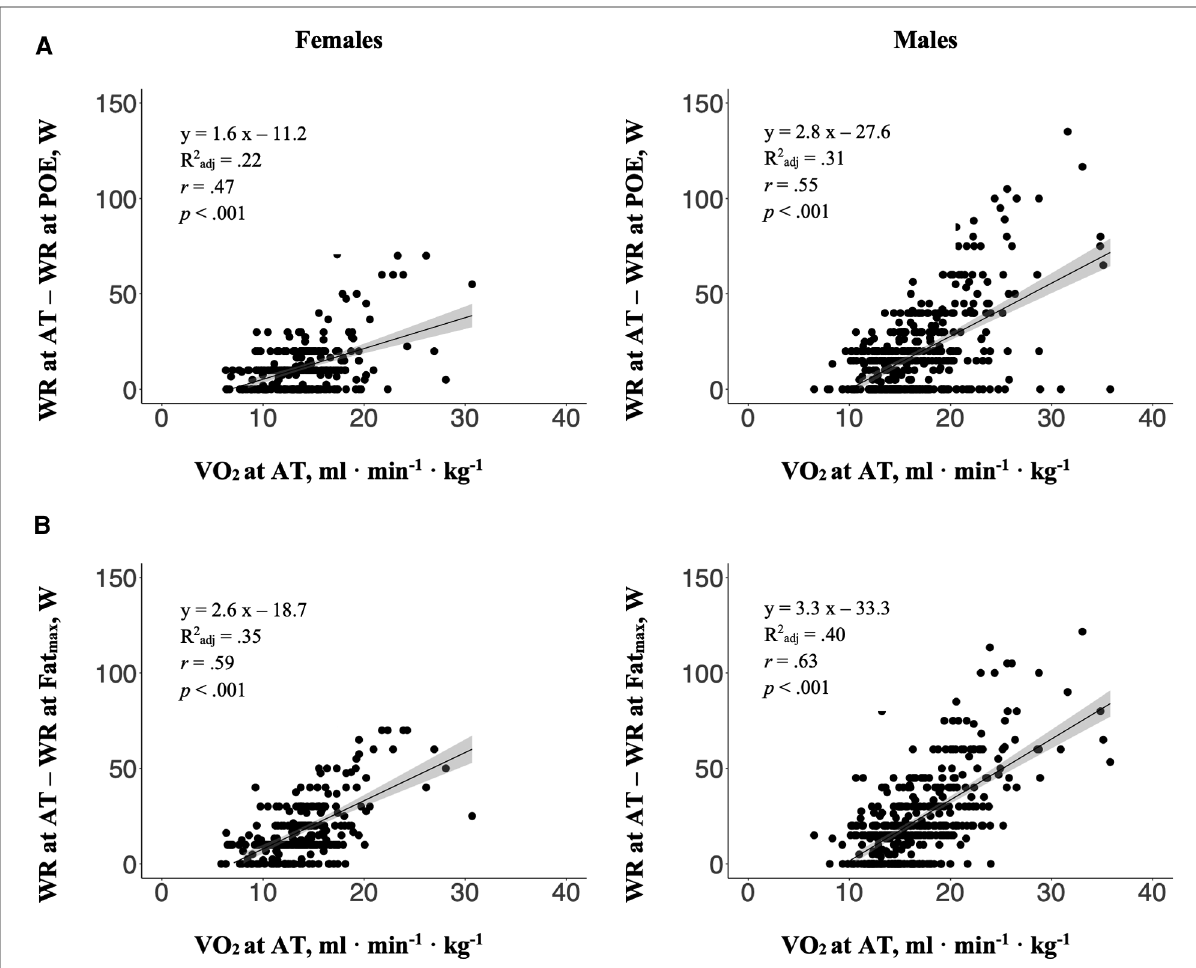
FIGURE 2 The relations between the aerobic capacity (in terms of VO 2 at AT) and the magnitude of the work rate (WR) differences ( A ) between POE and AT, and ( B ) between Fat max and AT, separately for females and males. Dark grey area: 95% con fi dence interval; R 2 adj : Adjusted R-square; r: Pearson ’ s product- moment correlation coef fi